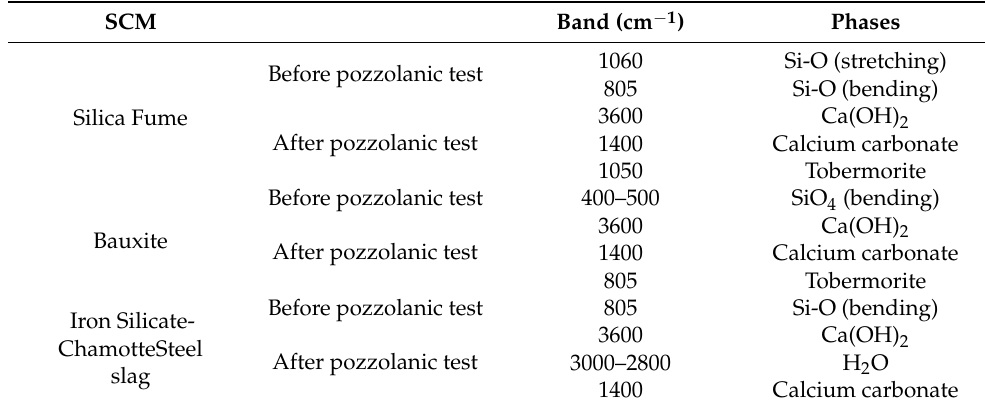
Table 6. FT-IR peaks of the SCM pozzolanic test